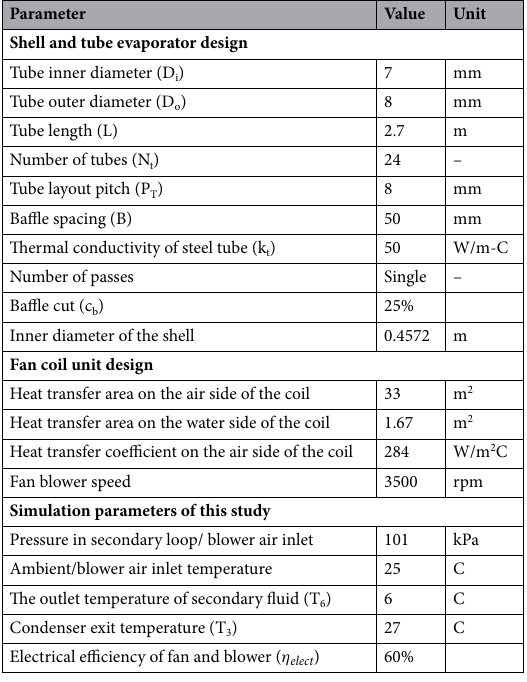
where (cid:31) E is the change in energy of a system, and this value is zero for any system operating under steady-state conditions. ˙ Q and ˙ W represents the heat transfer and work rates within a system. The mass flow rate and specific enthalpy at each state point is represented by